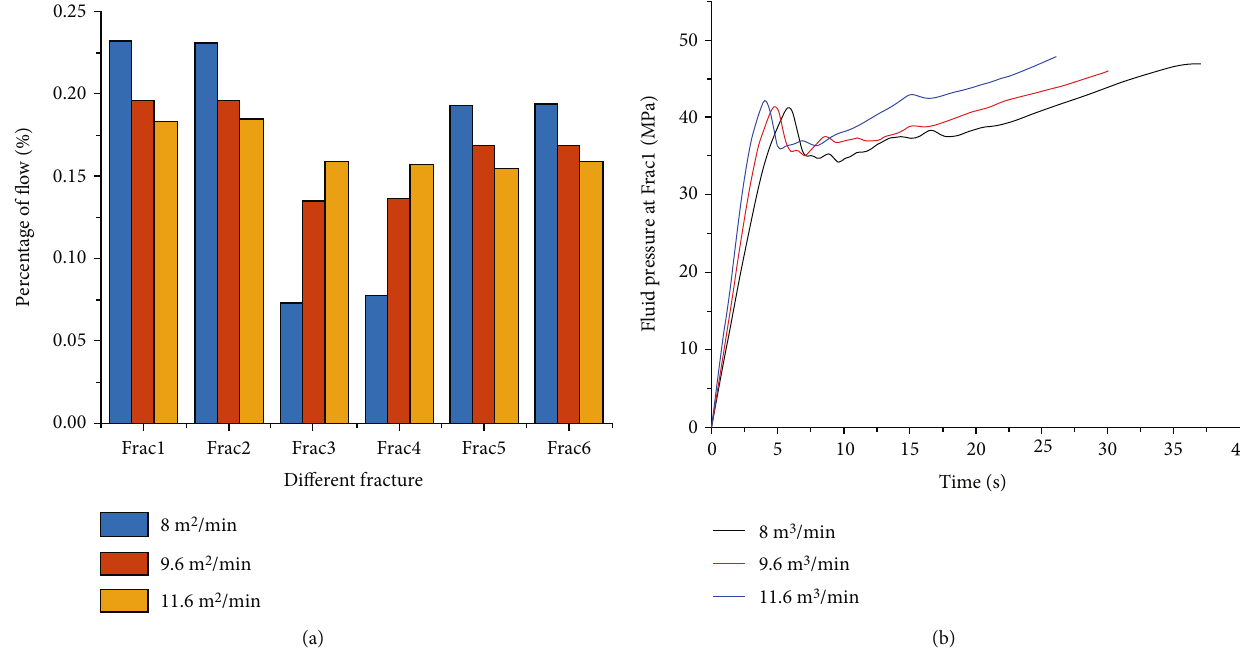
Figure 18: (a) Fluid distribution in fractures and fl uid pressure (b) for varying injection